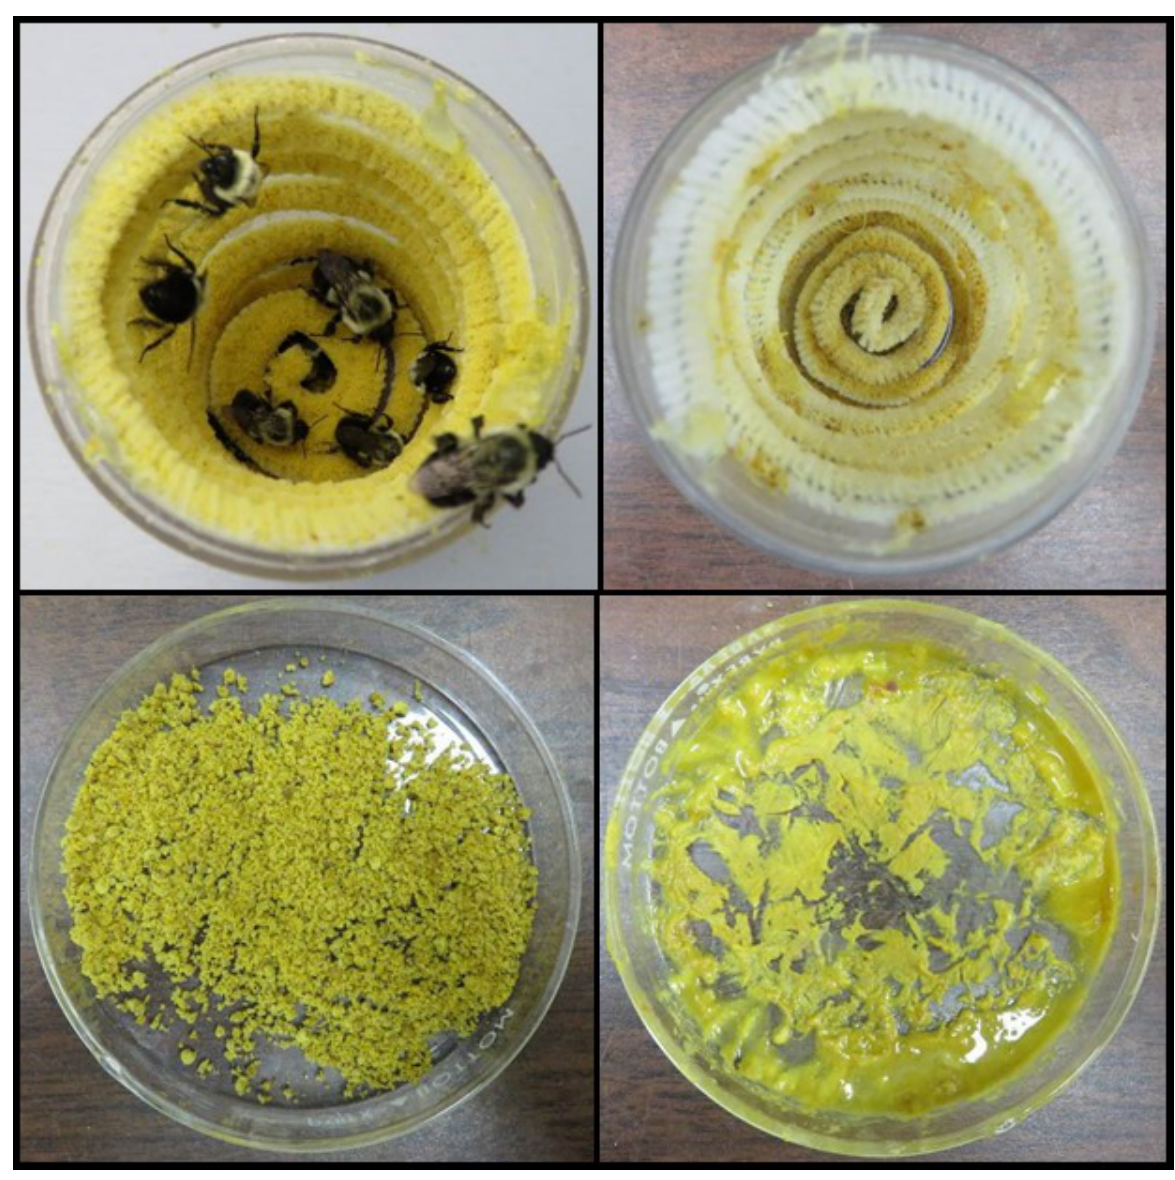
F IGURE 1. Chenille stem (top panels) and dish (bottom panels) feeders shortly after they are loaded with 4 grams of pulverized honeybee pollen (right panels) and 24 hours after being foraged in (left